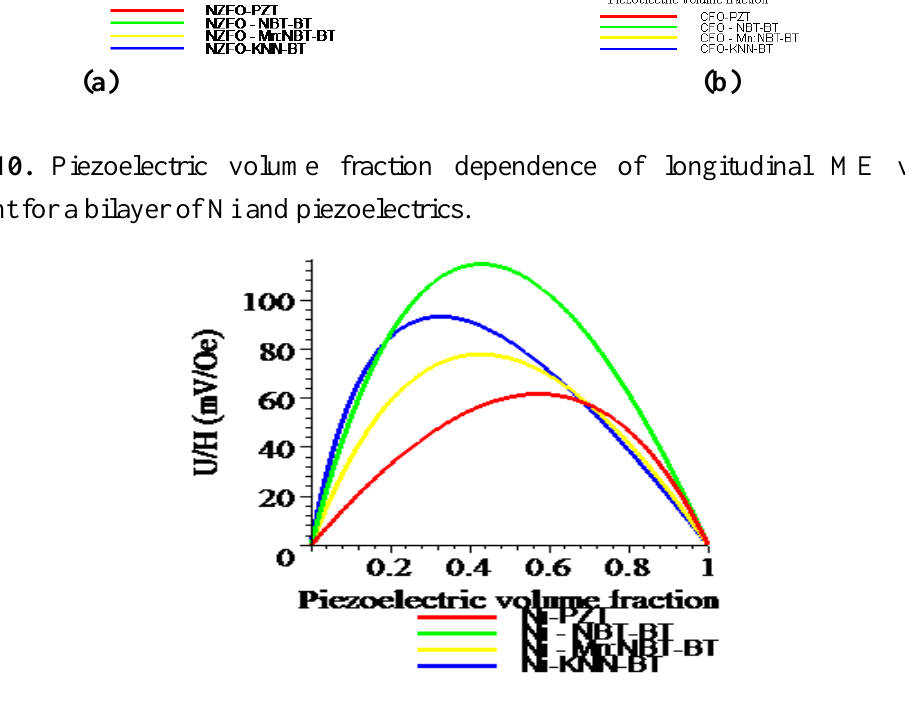
Figure 11. Piezoelectric volume fraction dependence of transverse ME voltage coefficient for a bilayer of Ni and